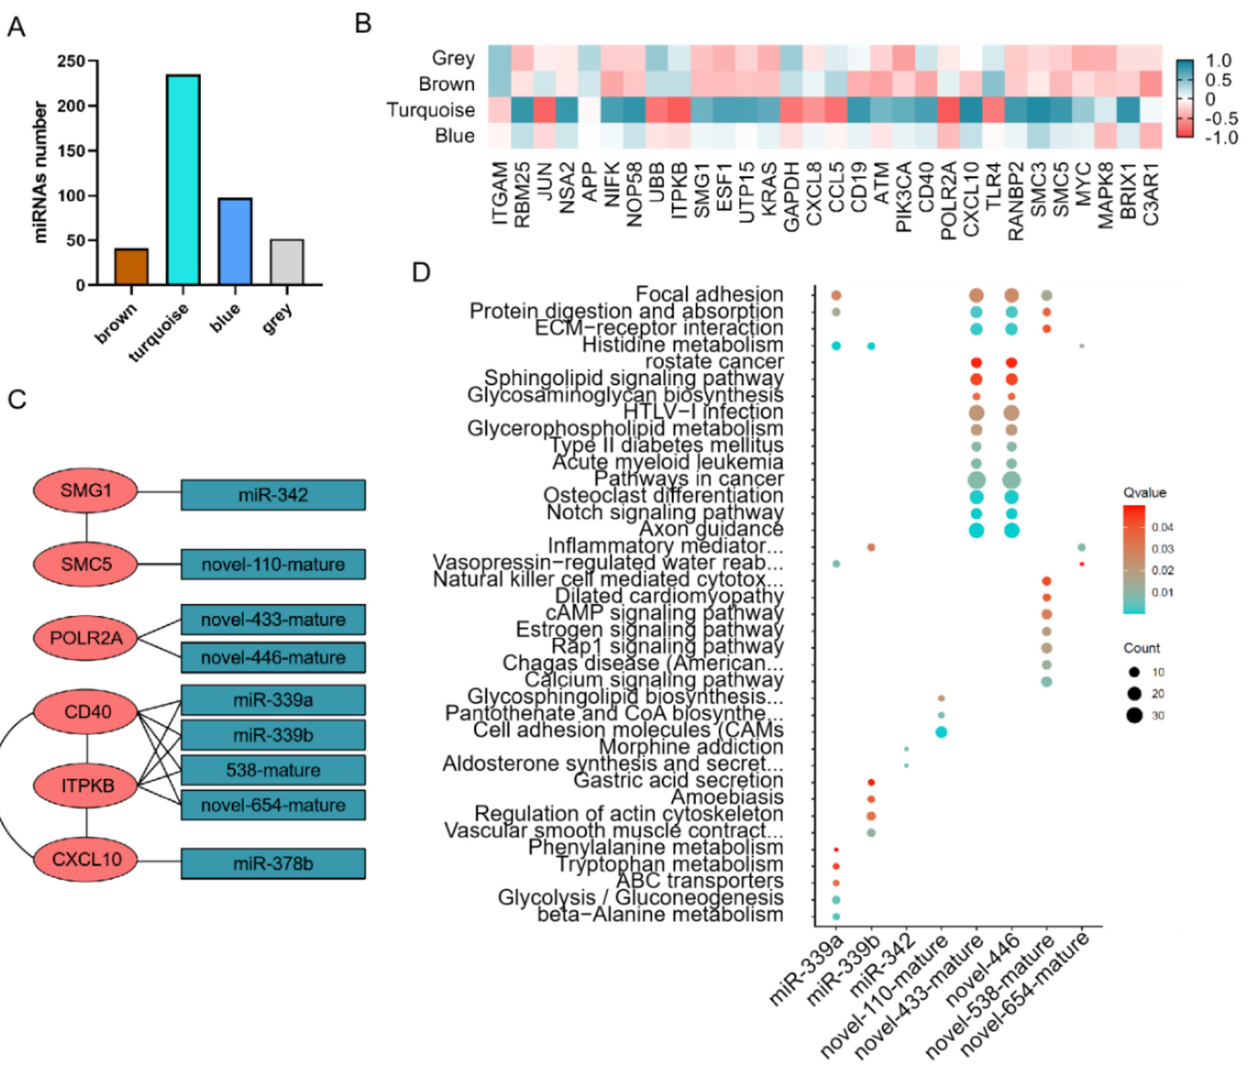
Figure 6. The relationship between hub genes in turquoise module and miRNA in different modules by WGCNA. ( A ) The number of miRNA in different modules. ( B ) Heatmap of the correlation between hub genes and miRNA in different modules. ( C ) Targeting relationship between hub genes and miRNA in different modules. ( D ) KEGG analysis of miRNA target genes.